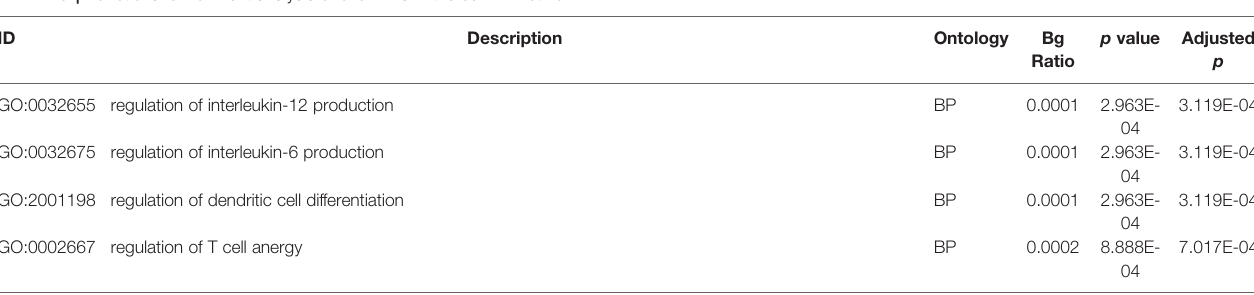
TABLE 5 | Functional enrichment analysis of circRNAs in the ceRNA